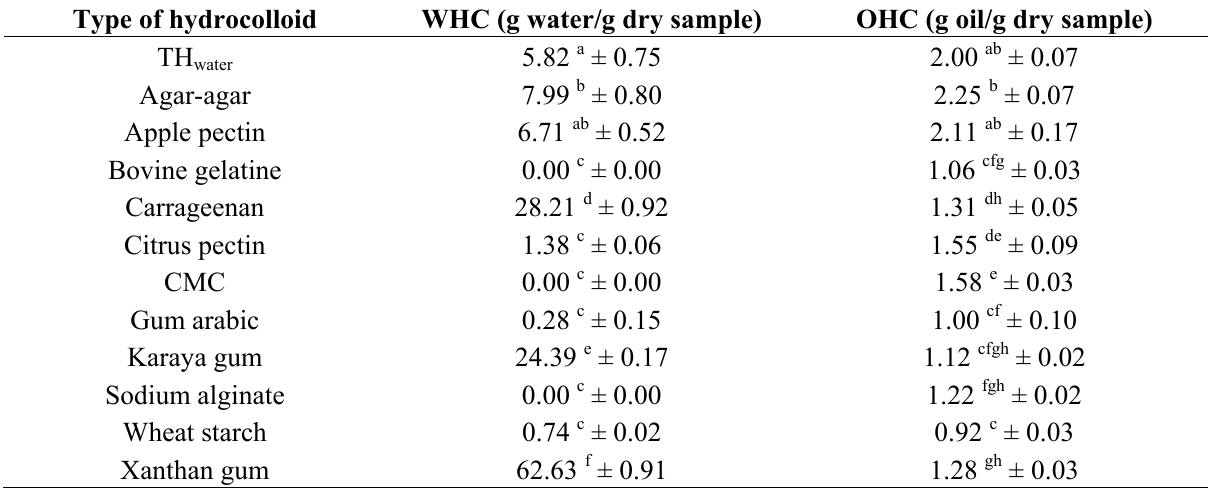
Table 3. Water holding capacity (WHC) and oil holding capacity (OHC) of Tamarillo and commercial